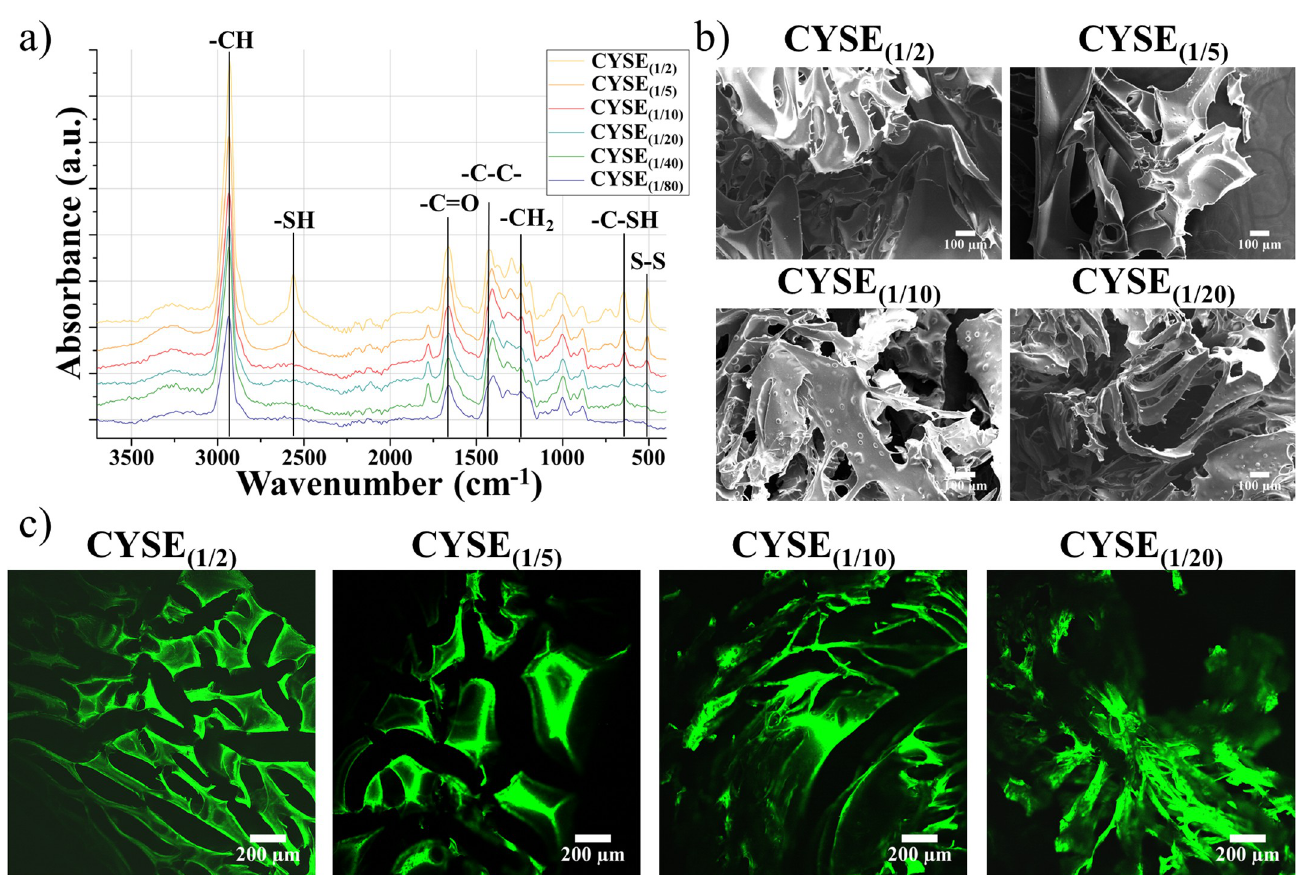
Fig 1. FT-RAMAN spectra of the dried hydrogels (a), SEM (b) and two photon images (c) of the freeze dried hydrogel matrices.